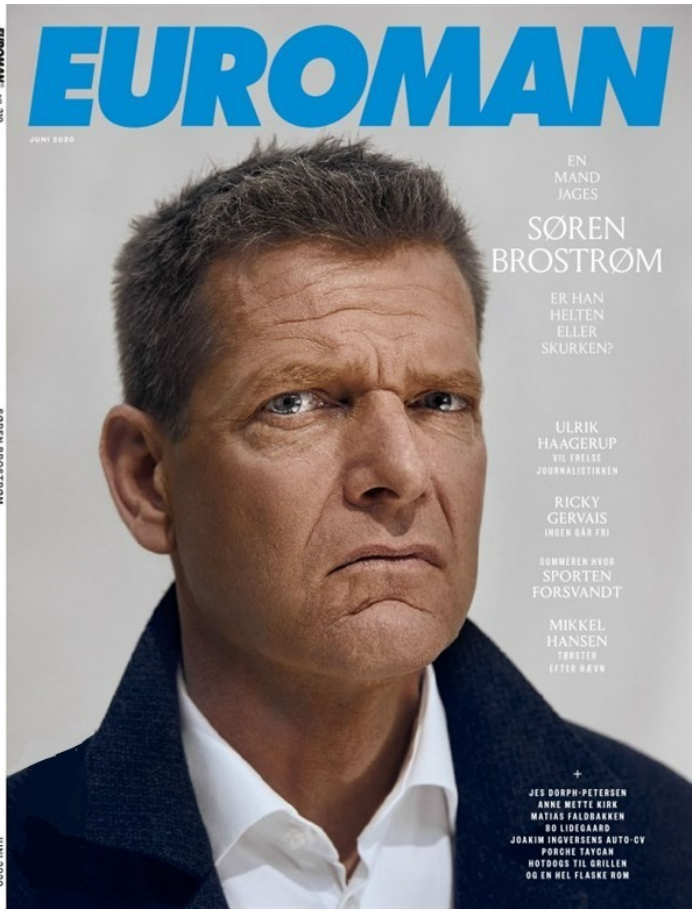
Figure 1. The Director-General at the front cover of Danish magazine Euroman in June